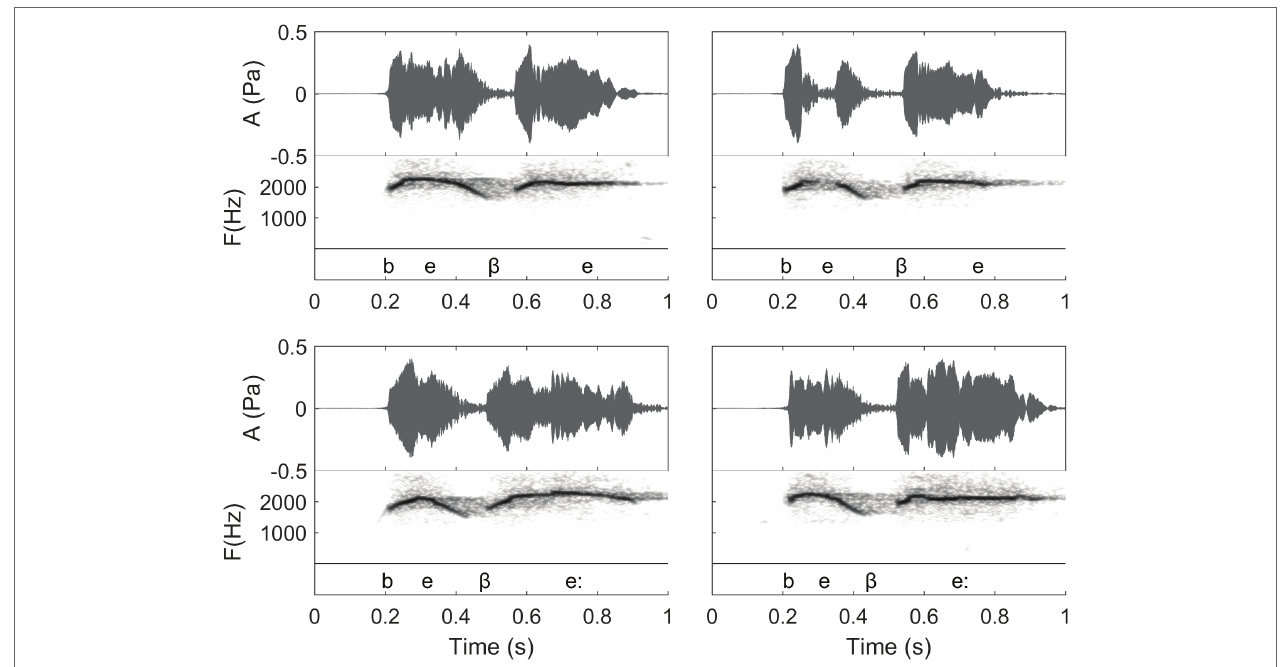
FIGURE 8 | Waveforms and spectrograms of the Spanish words “bebe” (top, meaning “he drank”) and “bebé” (bottom, meaning “baby”). In the figure, the transcription shows the details of the spoken phonetic pronunciation (note that the symbol “:” signals a long vowel. Moreover, the fact that the second “b” of these two words bears a different phonetic symbol than the first one shows a particularity of spoken Spanish that is transferred to whistling). Each word is whistled twice by the same whistler. In this figure, we thus can see differences between different repetitions of a same word that are accepted by the proficient listeners, as well as the influence of relative duration of the two vowels of these words. In “bebé” (bottom), the second syllable is longer than the first one. Note that the general duration of the words is the same because all these words are whistled in the same conditions, but for “bebé”, the first syllable is shortened in comparison with the one of “bebe” (Recordings and edition by Julien Meyer, listen to sound extracts in Meyer and Diaz,